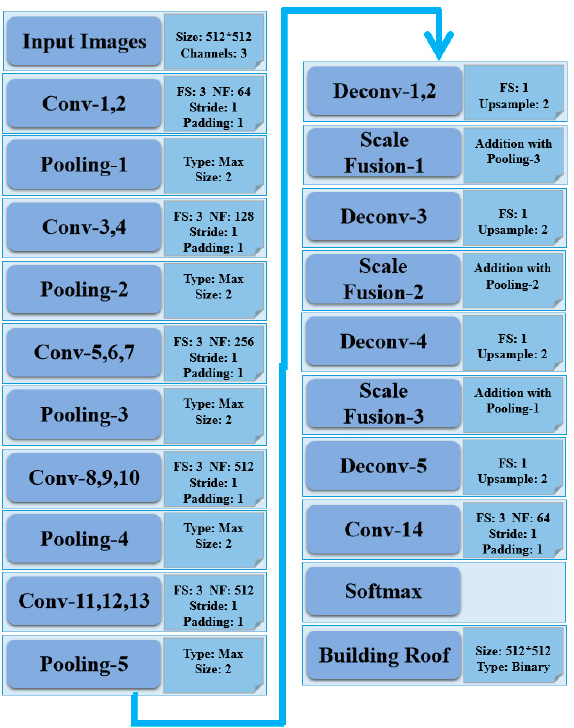
Figure 2. Architecture of the designed DCNN for building roof segmentation: Conv-N (N = 1–14) and Deconv-N (N = 1–5) denote the convolutional, deconvolutional fiters, respectively; Pooling-N (N = 1–5) are max pooling layers; Scale Fusion-N (N = 1–3) denotes the per-pixel addition layer for different features; FS, NF are filter size and number of filters.